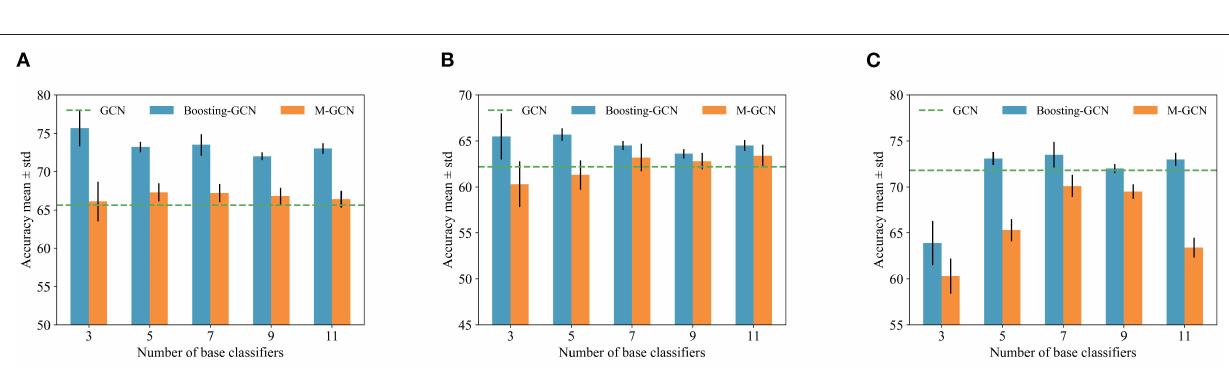
FIGURE 5 | Classification results of Boosting-GCN and M-GCN with different base classifiers. (A) Cora, (B) Citeseer, and (C)